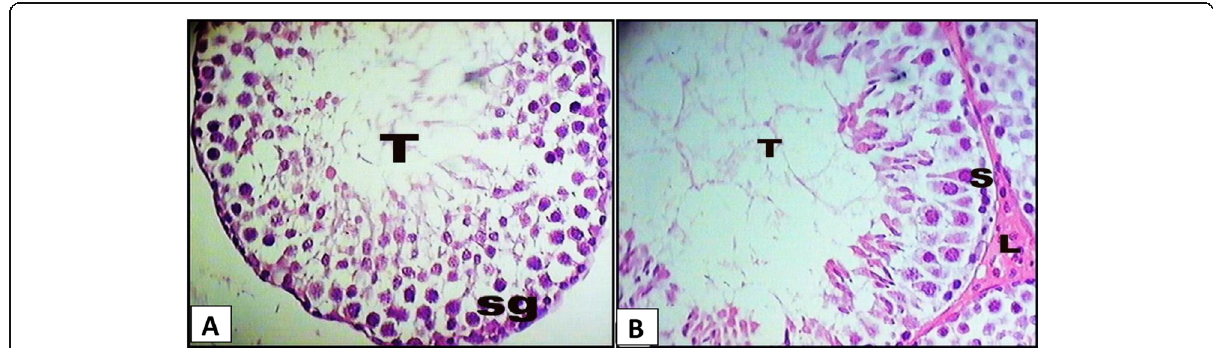
Fig. 3 a A photomicrograph of a cut section in the testis of group V showing certain improvement of histological findings, increased growing of spermatogenic cells, spermatogonia (sg) attaining its architecture, and many spermatozoa in seminiferous tubule (L). H&E (× 400). b A photomicrograph of a cut section in the testis of group VI showing discontinuous layer of spermatogonia, many developing spermatozoa with flagella in seminiferous tubule (T), and proliferated Leydig cells (L). H&E (×